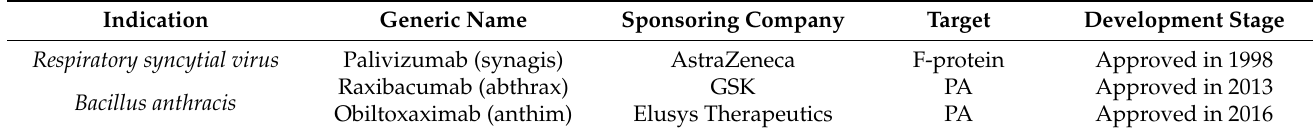
Table 1. Approved therapeutic antibodies for respiratory